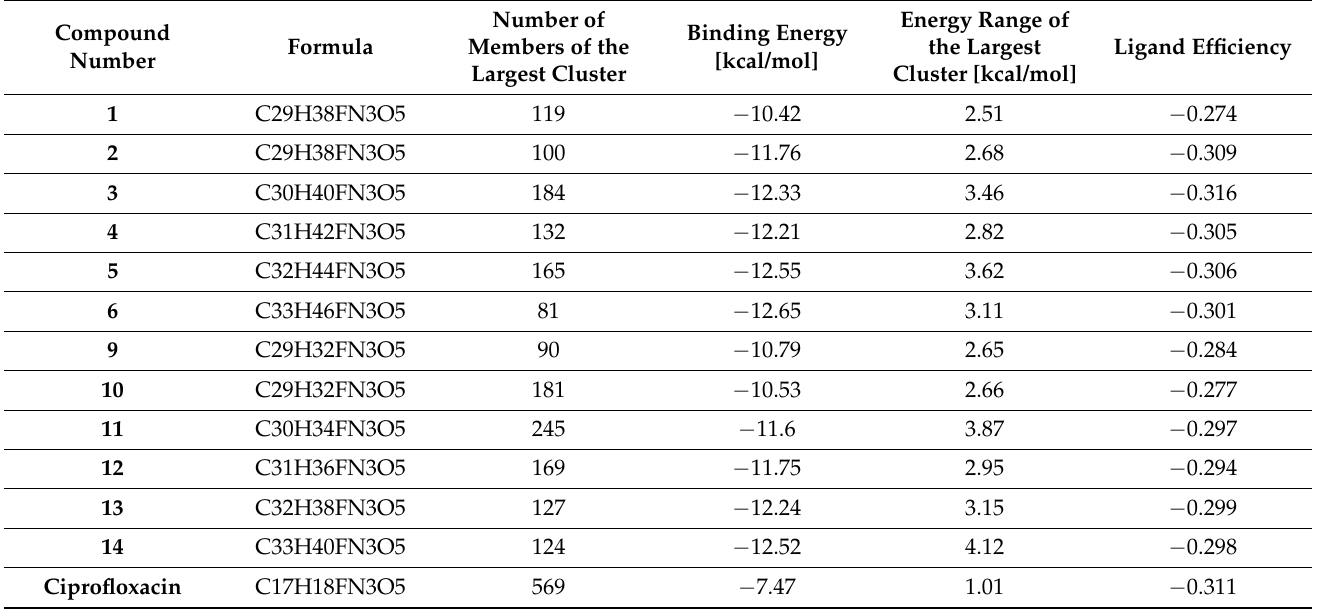
Table 6. Docking results for Ciprofloxacin and its monosubstituted